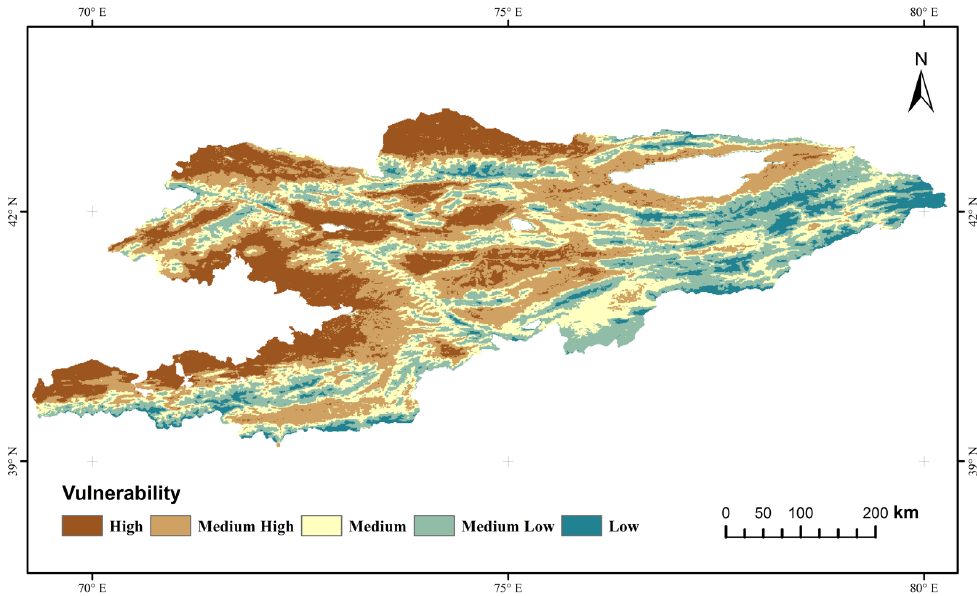
Figure 4. Agricultural system drought exposure index map of Kyrgyzstan.